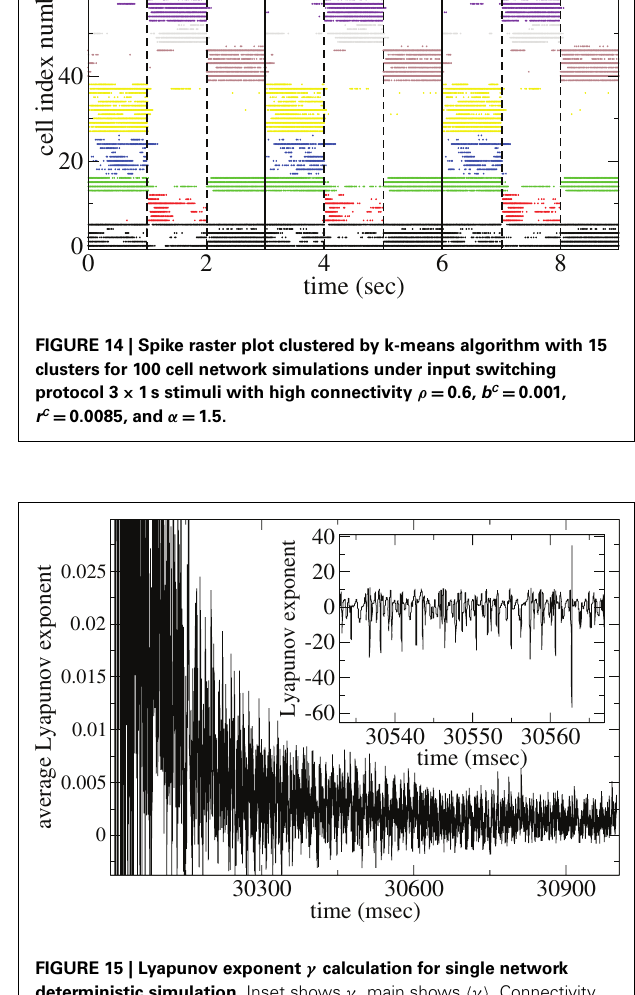
= 50, one continuous input g